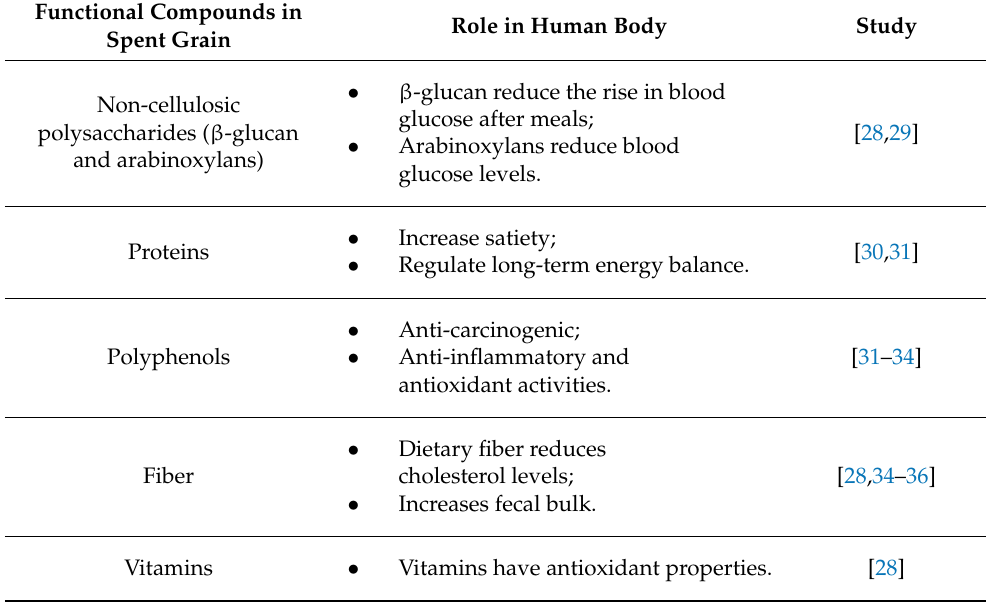
Table 1. Functional compounds in spent